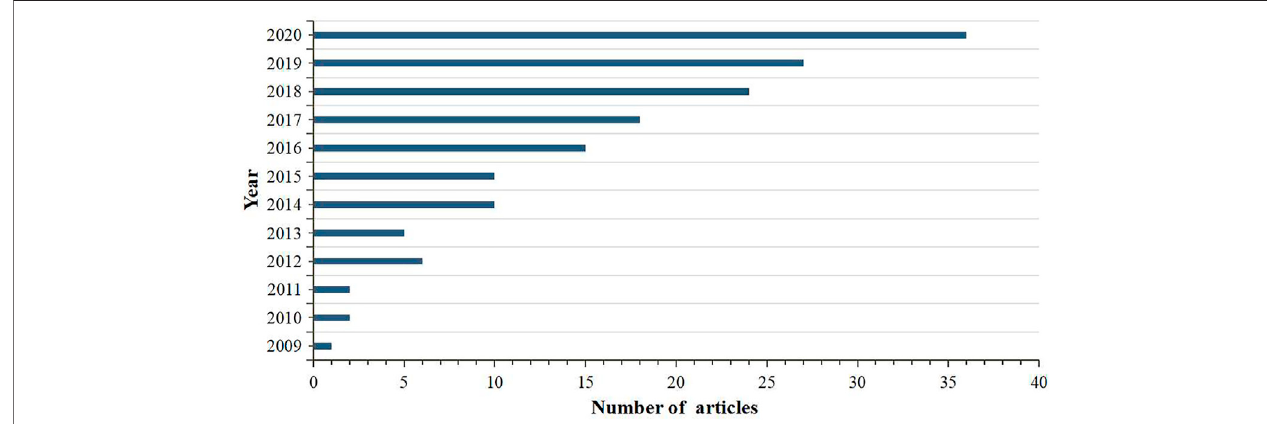
FIGURE 1 | The number of articles on researches between TCM and podocyte injury published from 2009 to 2020.